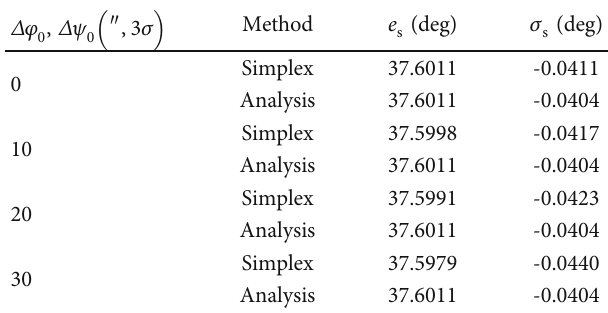
Table 5: Optimal navigation stars with di ff erent star sensor installation error.